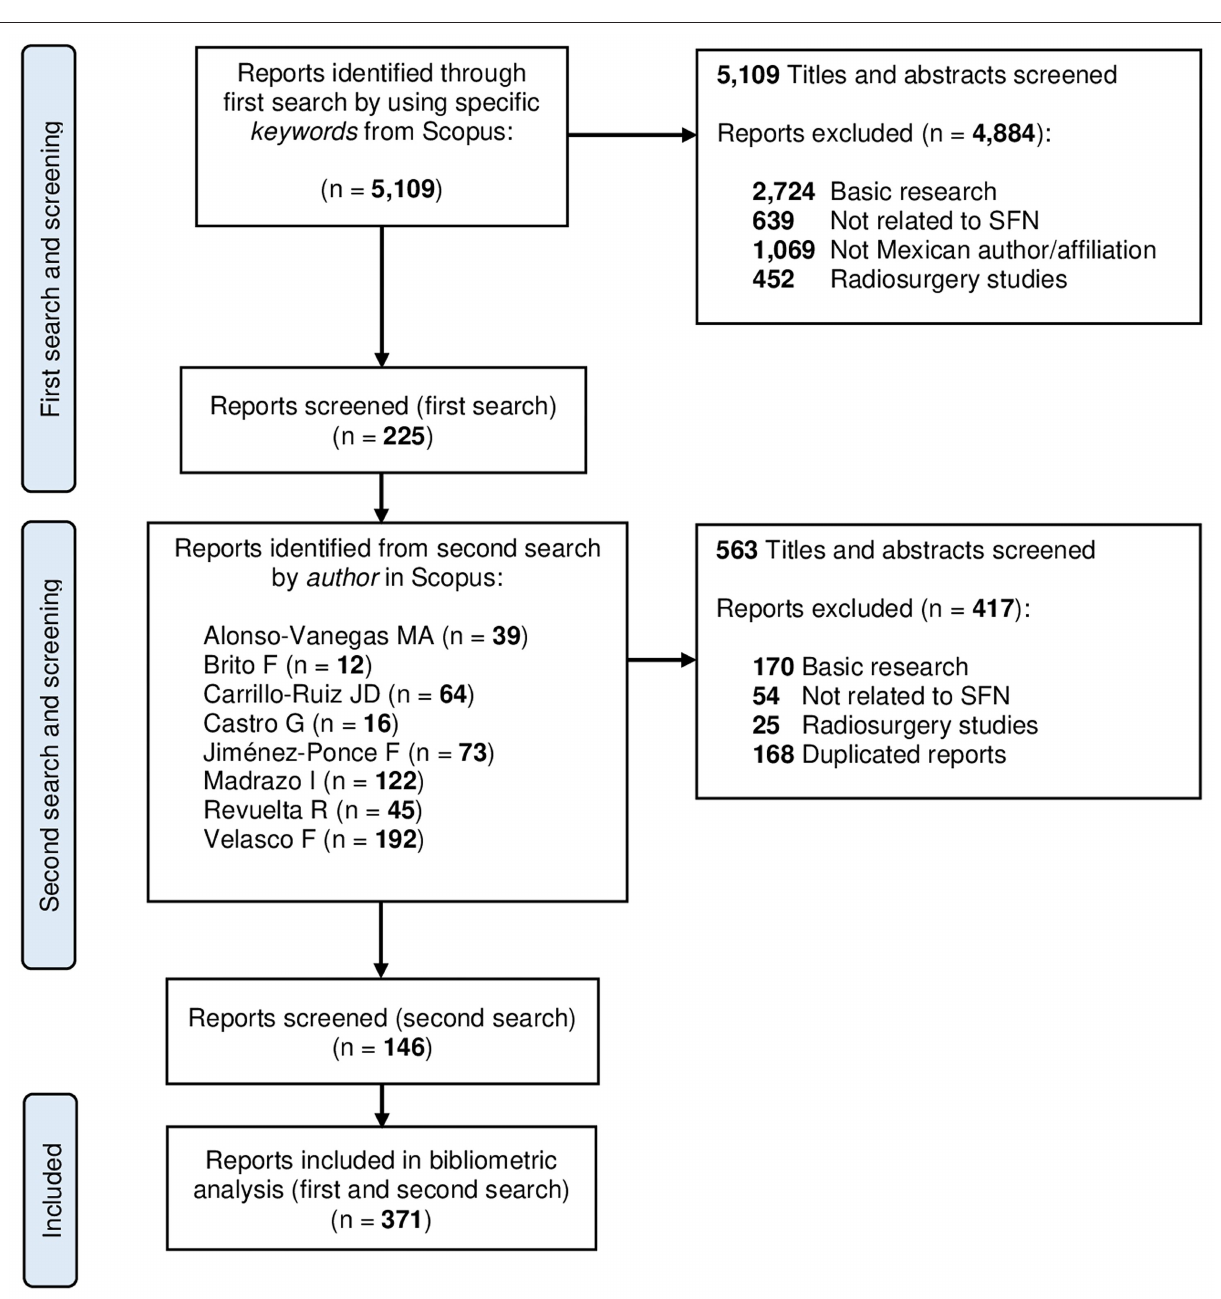
FIGURE 1 | Flow diagram for search